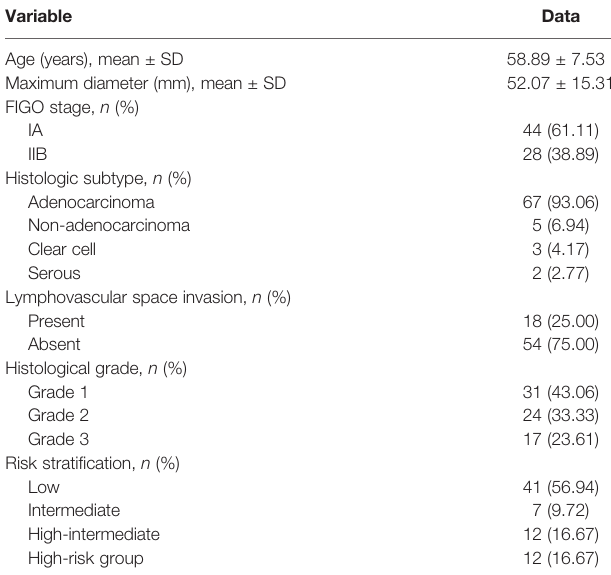
TABLE 2 | Clinicopathological features of the